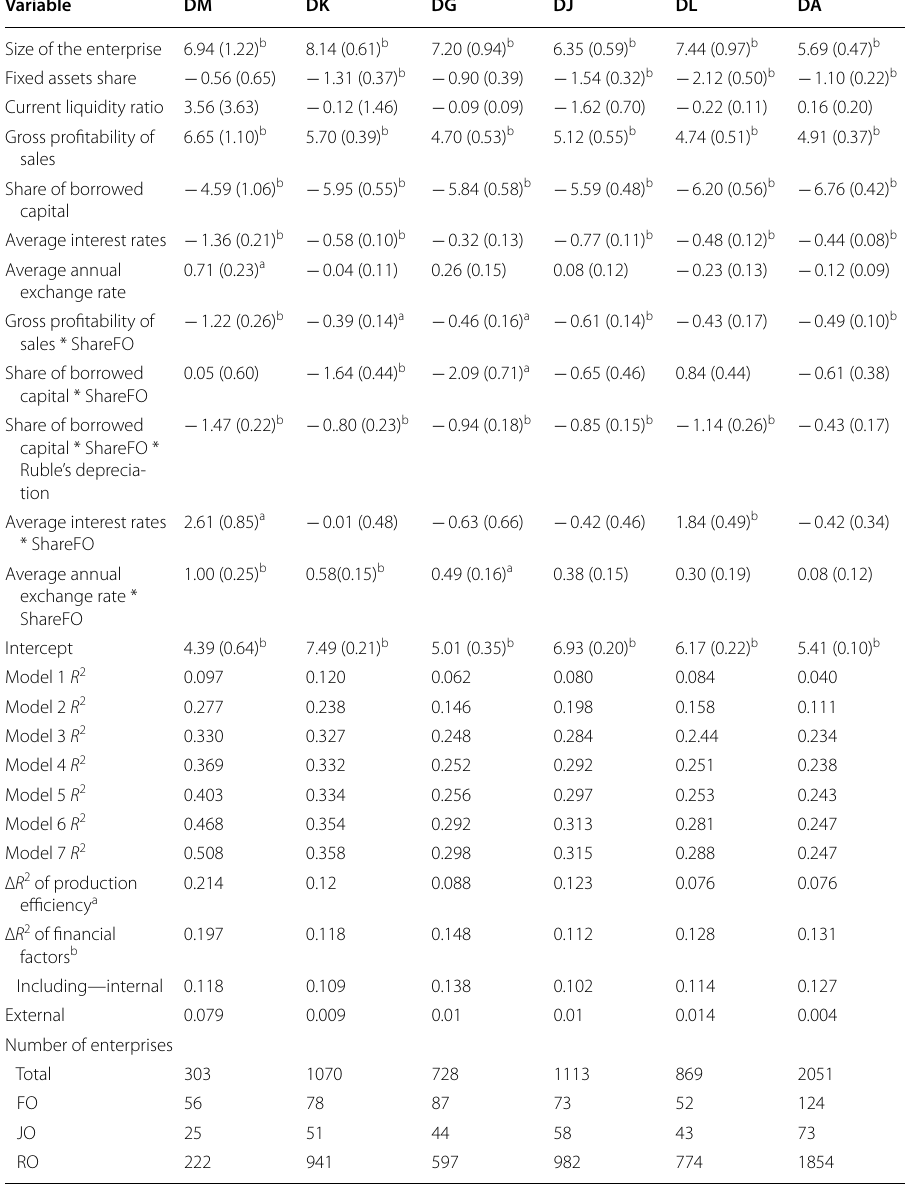
Regression results (fixed effects estimates, robust estimates) Standard errors are in parentheses. The coefficients and standard errors are given according to model 7. All constructed models (models no. 1–7) for each type of economic activities are highly significant ( p ≪